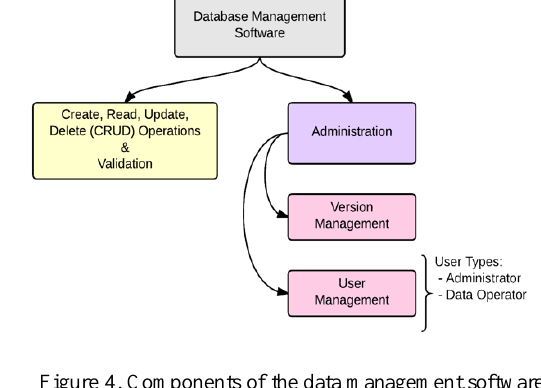
Figure 4. Components of the data management software